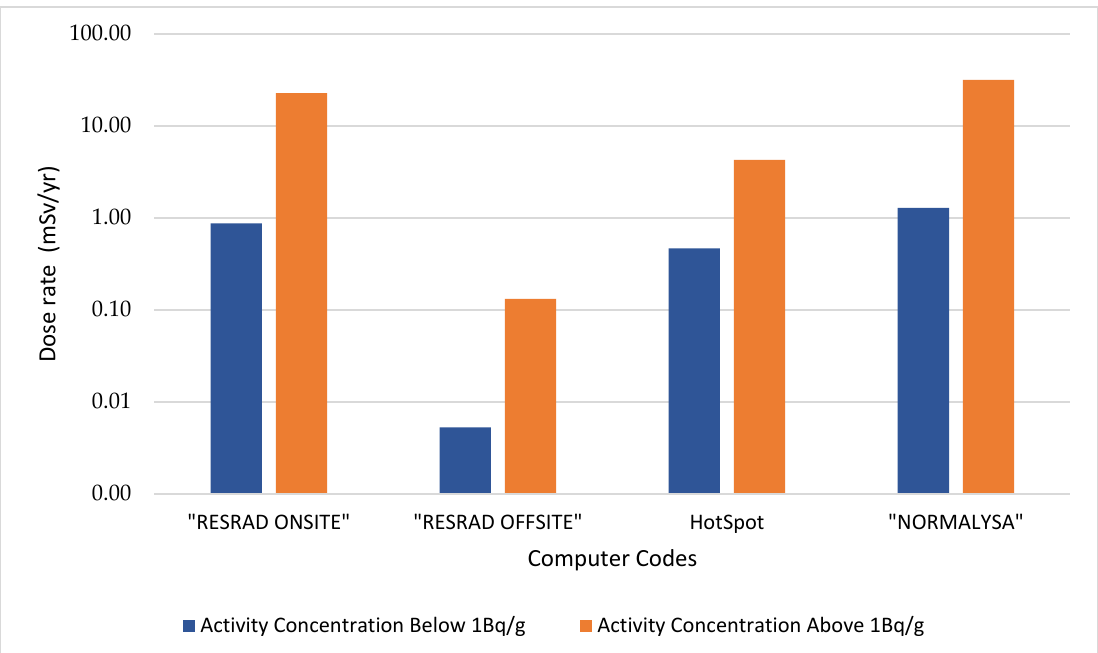
Figure 9. Comparison graph for the four computer codes.